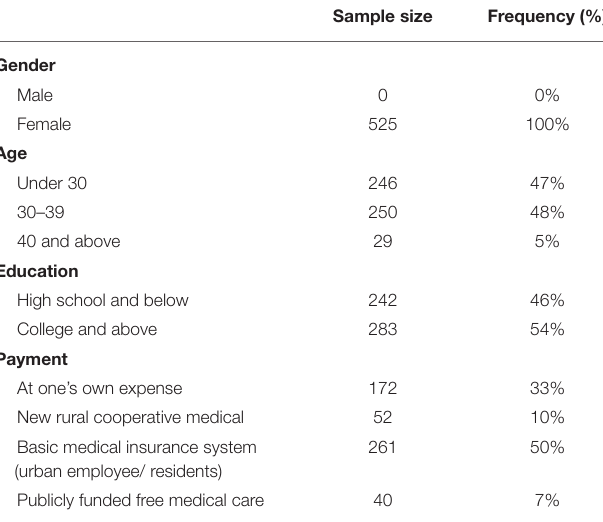
TABLE 2 | Respondent background information for the case